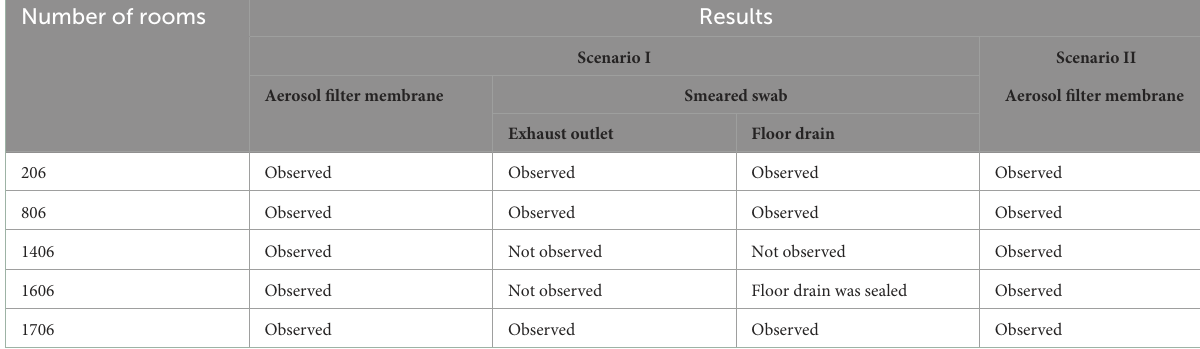
TABLE 2 The results of on-site simulation experiments in building